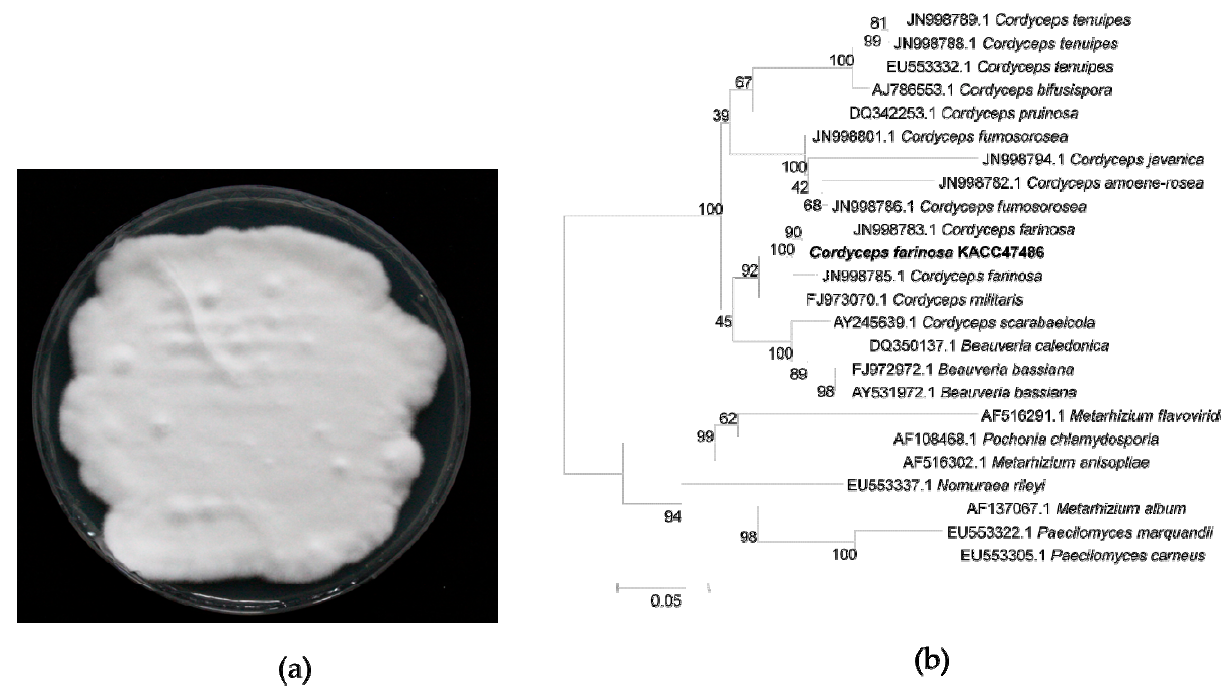
Figure 2. Identification of Cordyceps farinosa (KACC47486). ( a ) Strain of C. farinosa (KACC47486) cultured on PDA medium for two weeks; ( b ) Phylogenetic analysis using Neighbor-Joining method based on partial sequences of the ITS rDNA region.